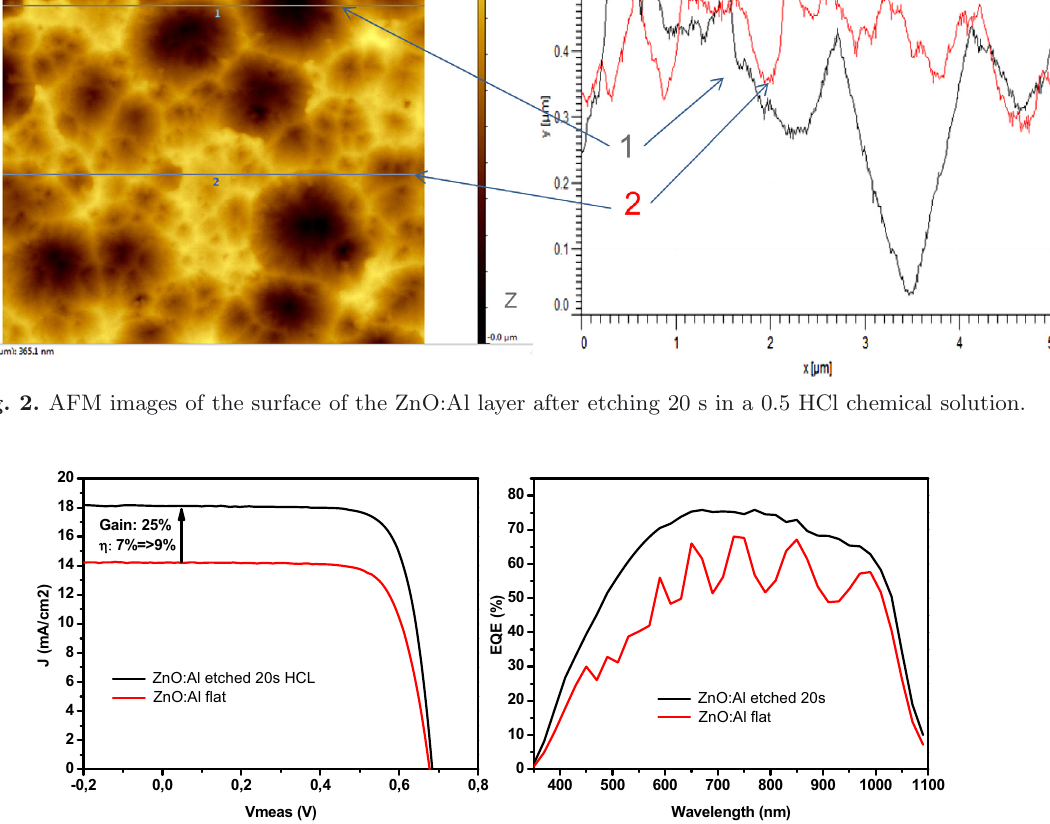
Fig. 3. Comparison of EQE and I - V under 1 sun illumination of flat and textured ZnO:Al.